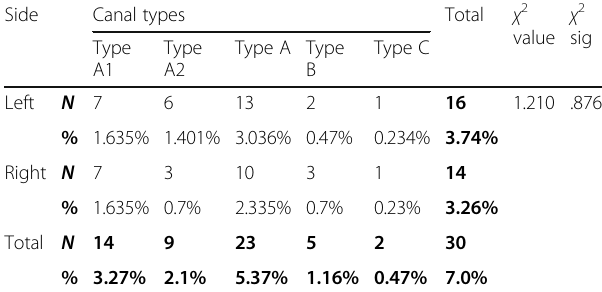
Table 5 Description of the different linear measurements